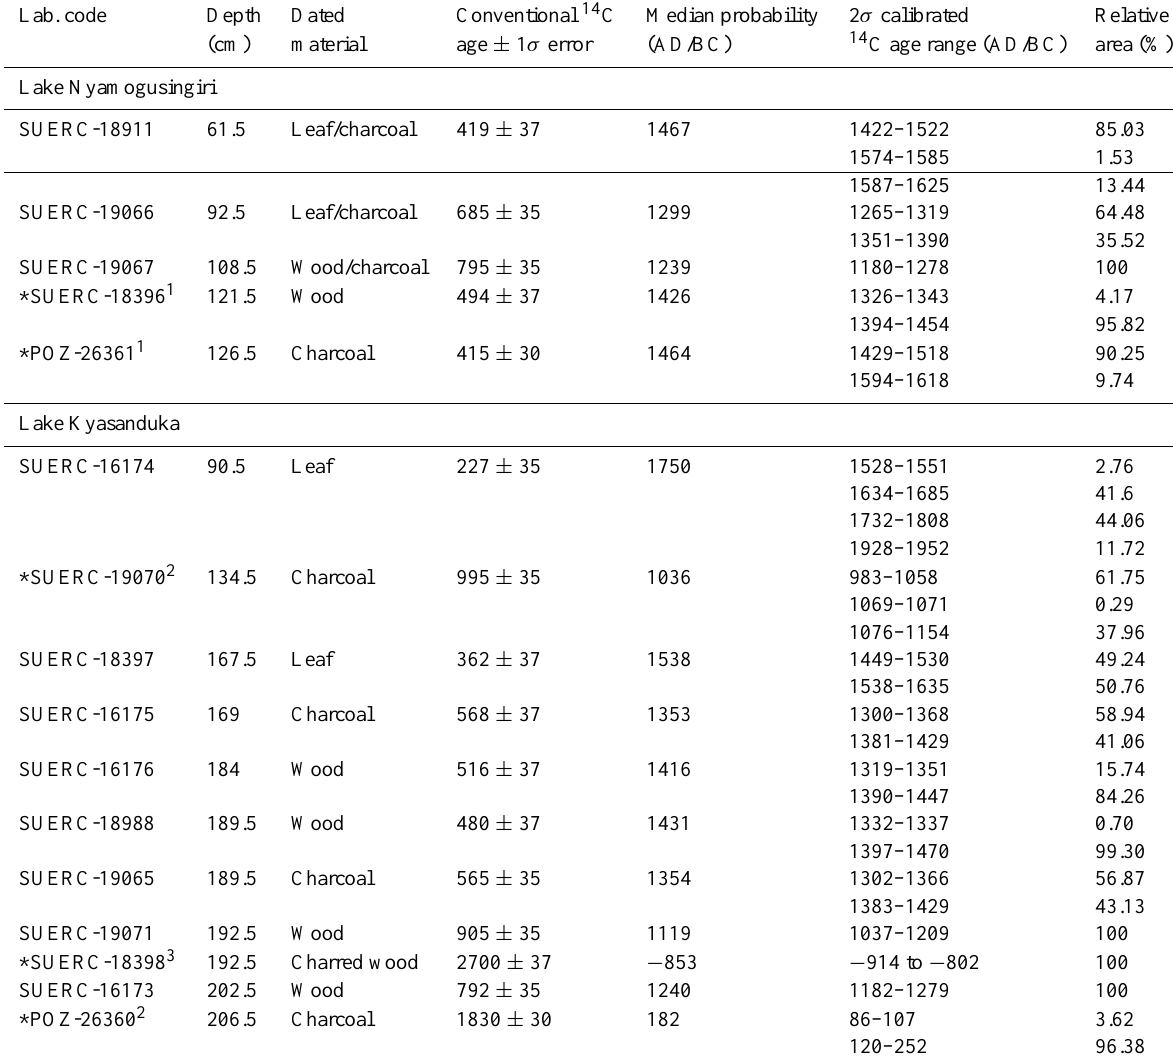
Table 1. Calibrated radiocarbon ages for all samples from Lake Nyamogusingiri and Lake Kyasanduka (* denotes date rejected from age